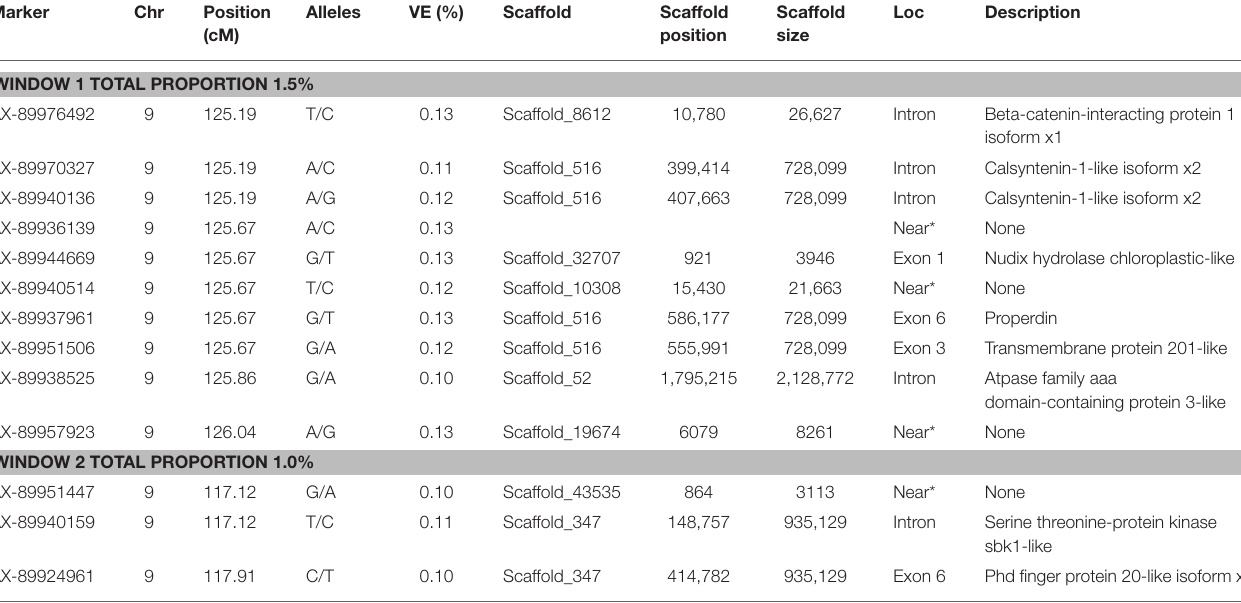
Scaffold Loc Description position size